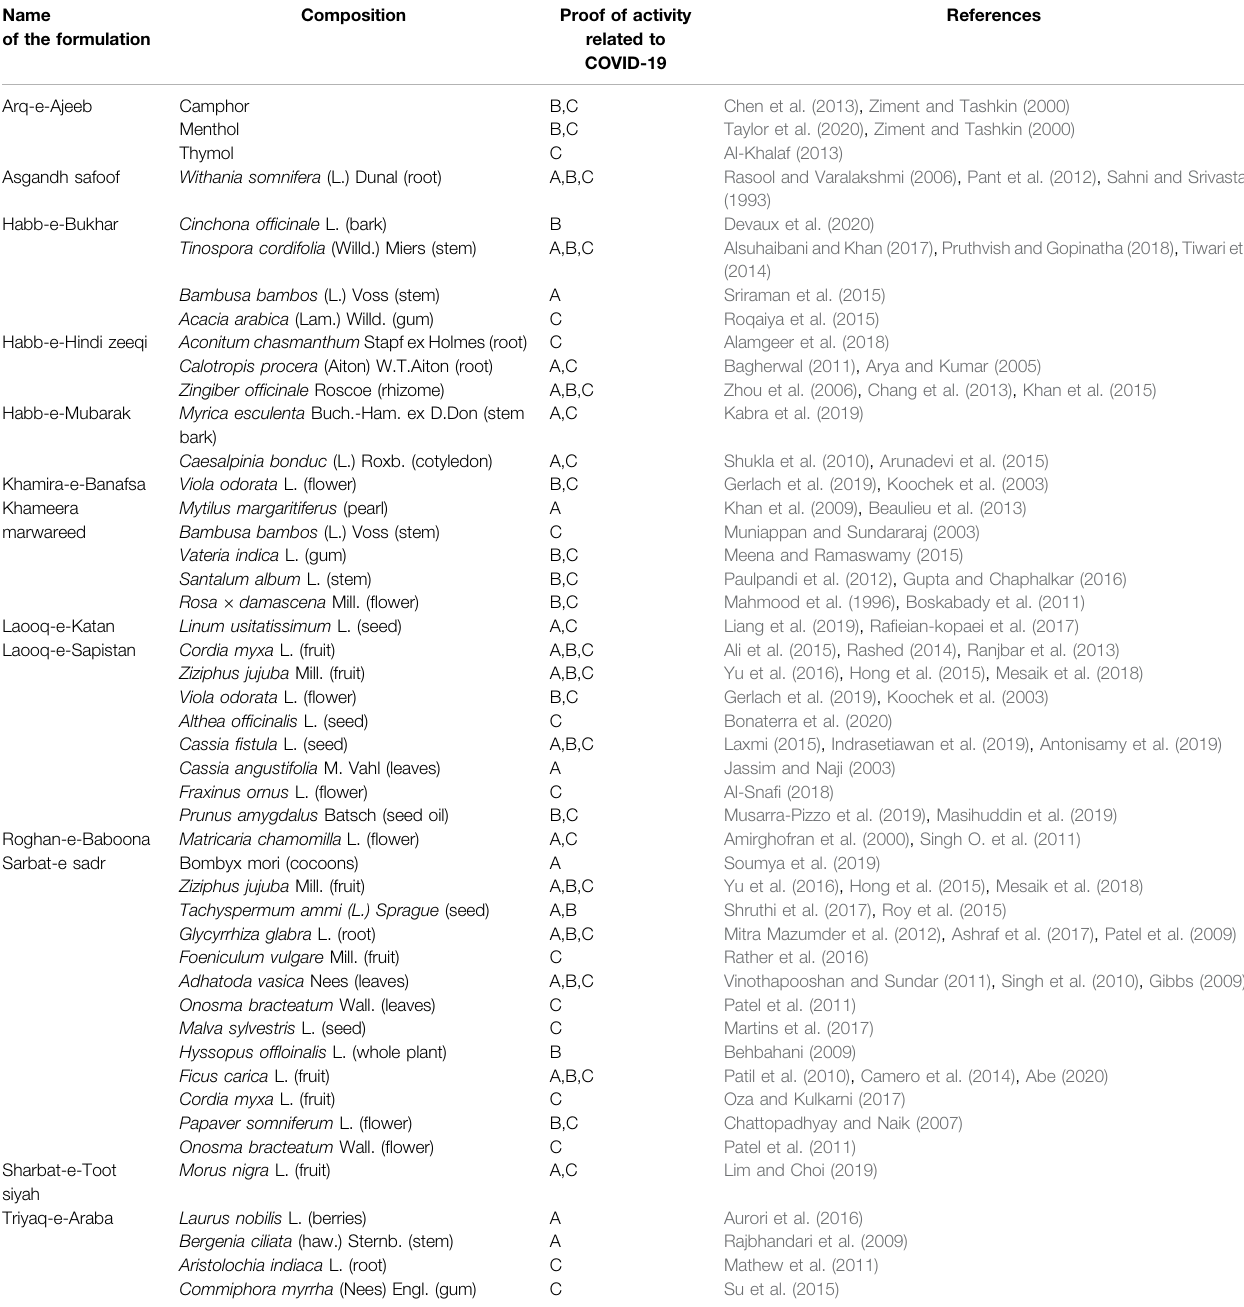
TABLE 3 | AYUSH recommended prophylactic approach through Unani formulation. Ref: AYUSH Ministry of Health Corona Advisory – D.O. No. S. 16030/18/2019- NAM; dated: 06th March, 2020. Name of the